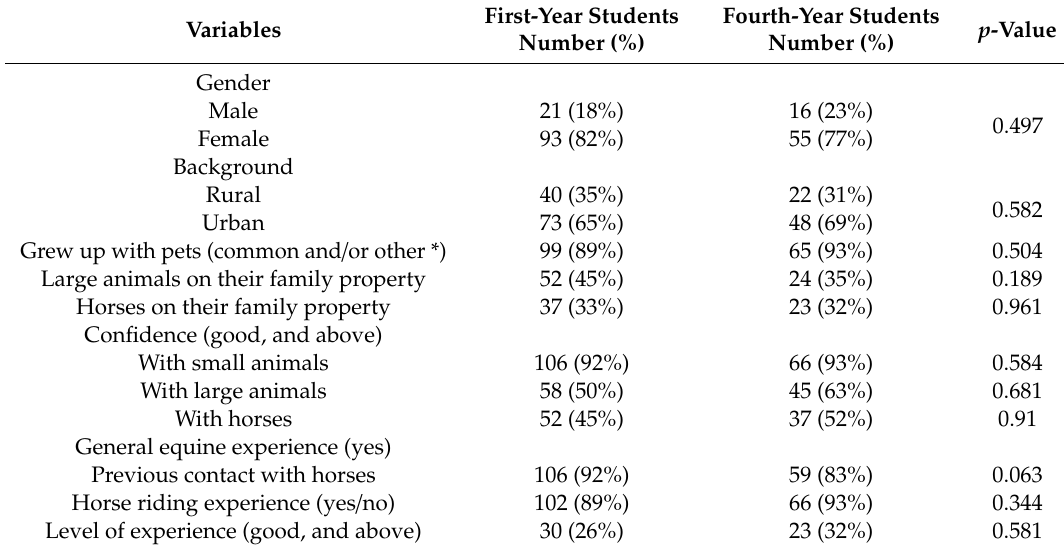
Table 2. Number and percentage of first- and fourth-year veterinary students by gender, background, confidence around animals, and equine experience. p -values were obtained from binary logistic regressions when comparing the distribution of variables between first- and fourth-year students. First-Year Variables